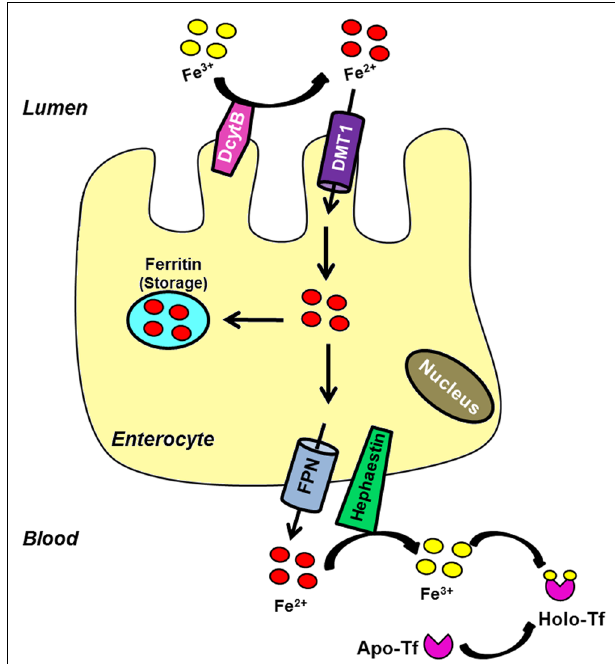
FIGURE 1 | Intestinal iron uptake. Luminal ferric iron is reduced (DcytB) at the apical membrane of enterocytes. Ferrous iron is then transported into the cell by the brush border protein DMT1. Once inside the cell, iron can bind to ferritin to be stored or exported across the basolateral surface by FPN.The ferroxidase hephaestin converts it into the ferric form. Ferric iron is bound by apo-Tf to circulate into the